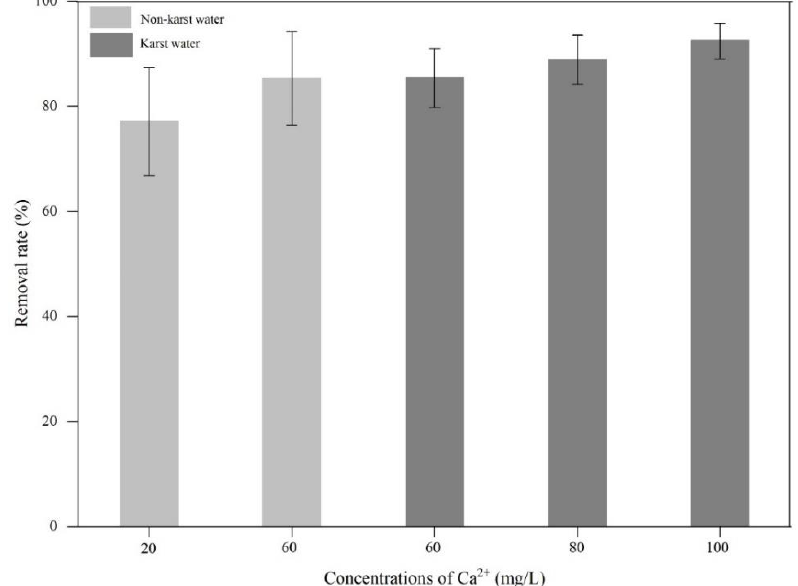
Figure 2. The removal of lead (Pb) in water by Eichhornia crassipes under different concentrations of calcium ion (Ca 2+ ).